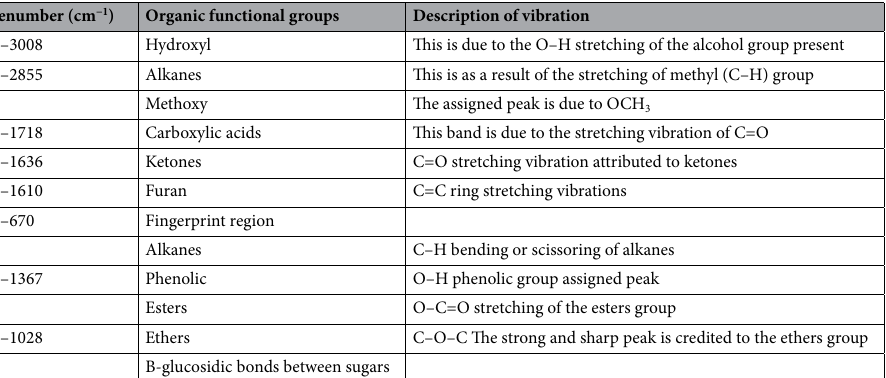
Table 14. Organic functional groups detected in the raw and pretreated biomass.